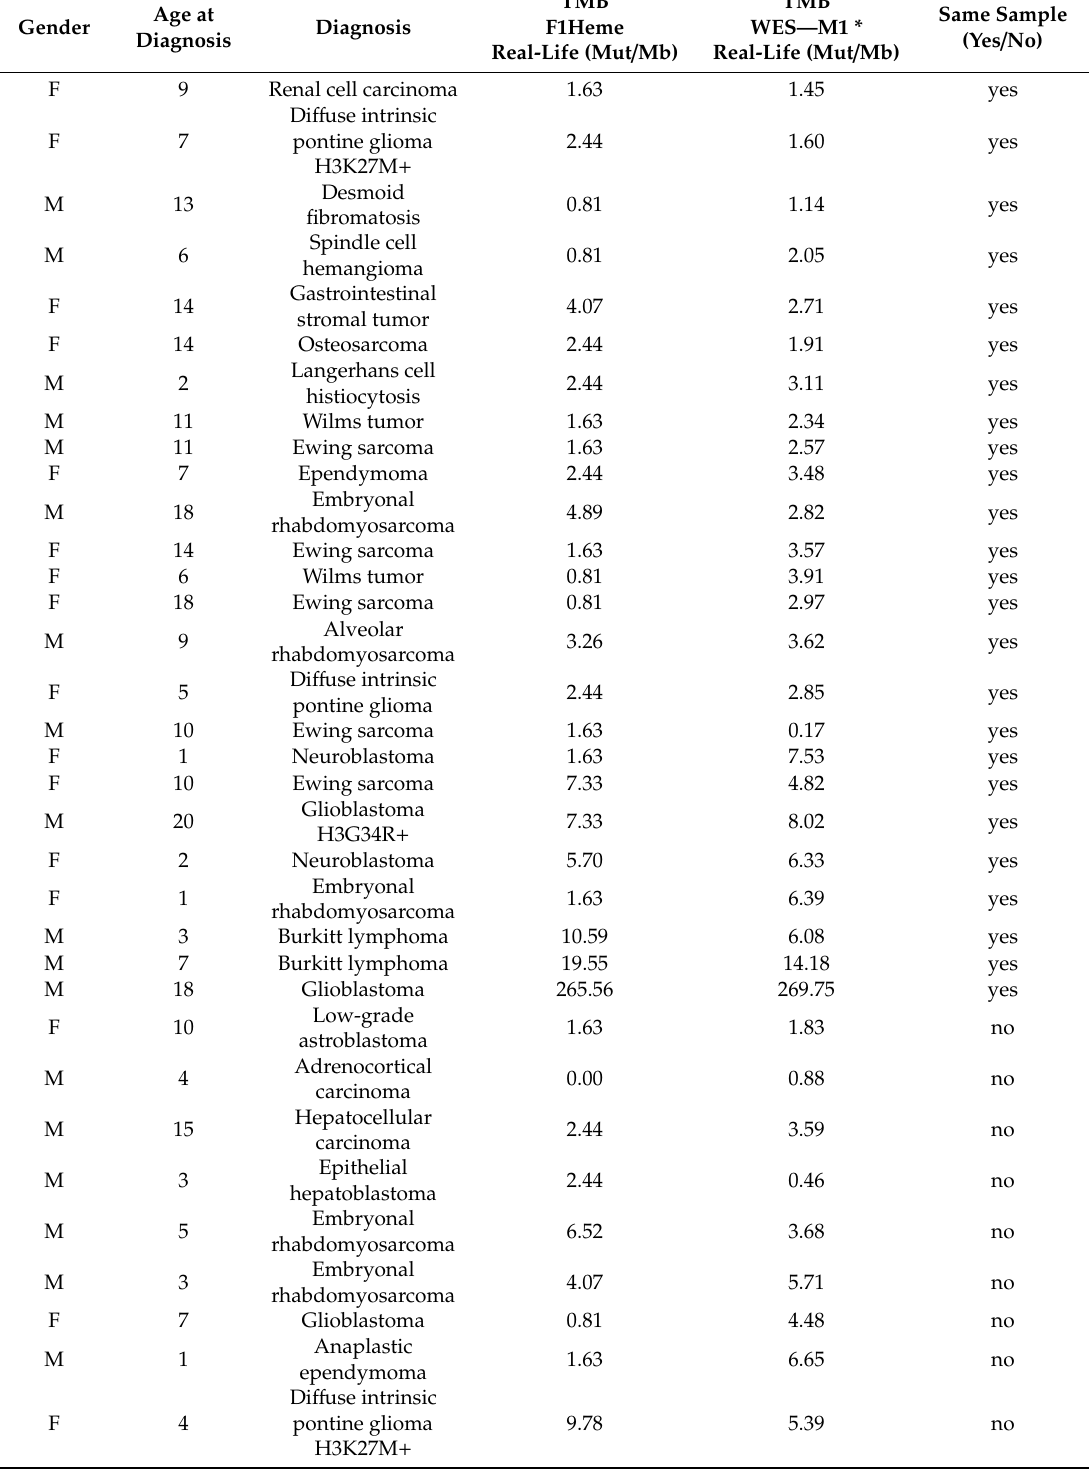
Table 2. Comparison of TMB determined by real-life WES and the FMI laboratory testing service FoundationOne Heme